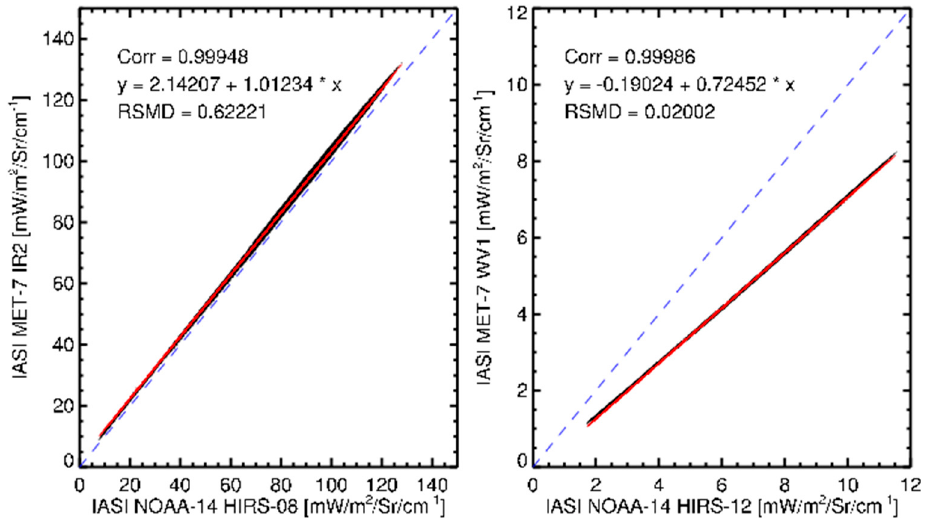
Figure 4. Example of deriving spectral band adjustment factors (SBAF). A linear fit between the two radiances are shown using the red line. There were 202,477 data points that were used to determine the linear fit parameters.